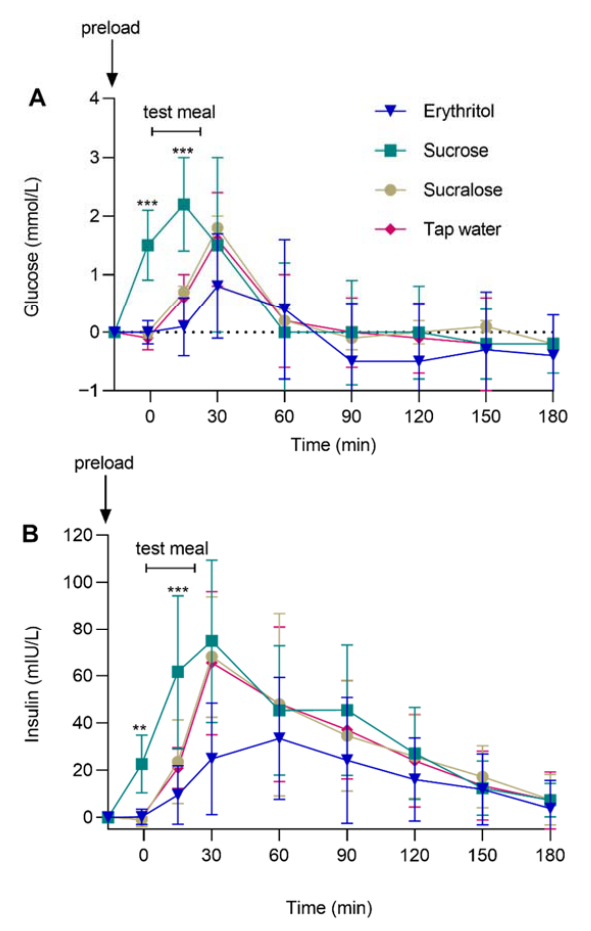
Figure 4. ( A ) Glucose and ( B ) insulin concentrations after oral administration of preloads containing either 50 g erythritol, 33.5 g sucrose, 0.0558 g sucralose, or tap water, and after the ad libitum test meal. Data are shown as mean ± SD, and baseline values are presented. Statistics: linear mixed models followed by planned contrasts with Holm correction for multiple testing. *** p Holm < 0.001 and ** p Holm < 0.01 for erythritol vs. sucrose. n = 20.